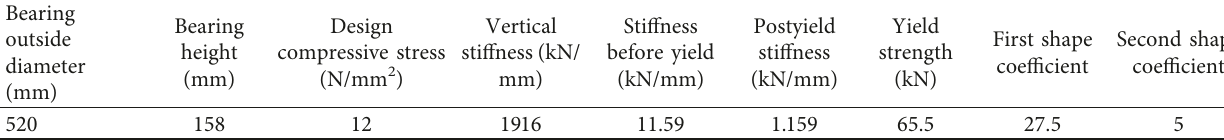
Table 1: LRB500 isolation bearing parameters.